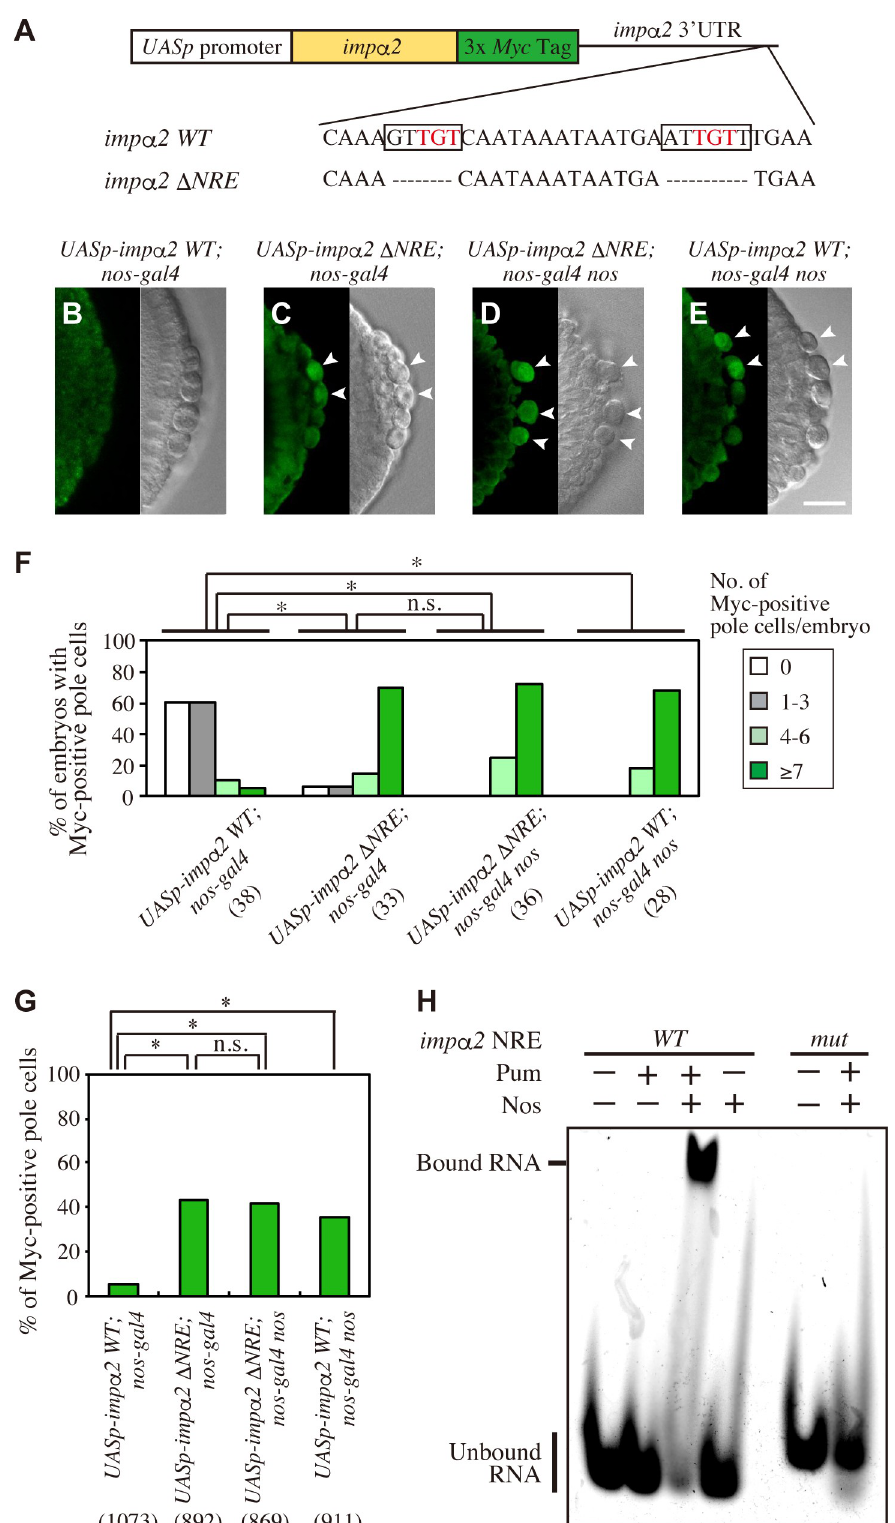
Fig 2. Nos represses imp α 2 translation in an NRE-like sequence–dependent manner. ( A ) Schematic representation of UASp-imp α 2 WT and UASp-imp α 2 Δ NRE , which express imp α 2 WT and imp α 2 Δ NRE mRNAs, respectively.